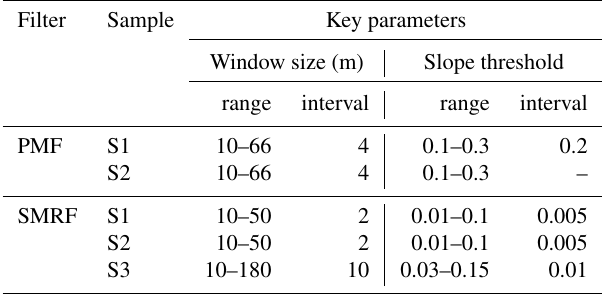
Table 1. Key parameter settings of the morphological filters tested in the three